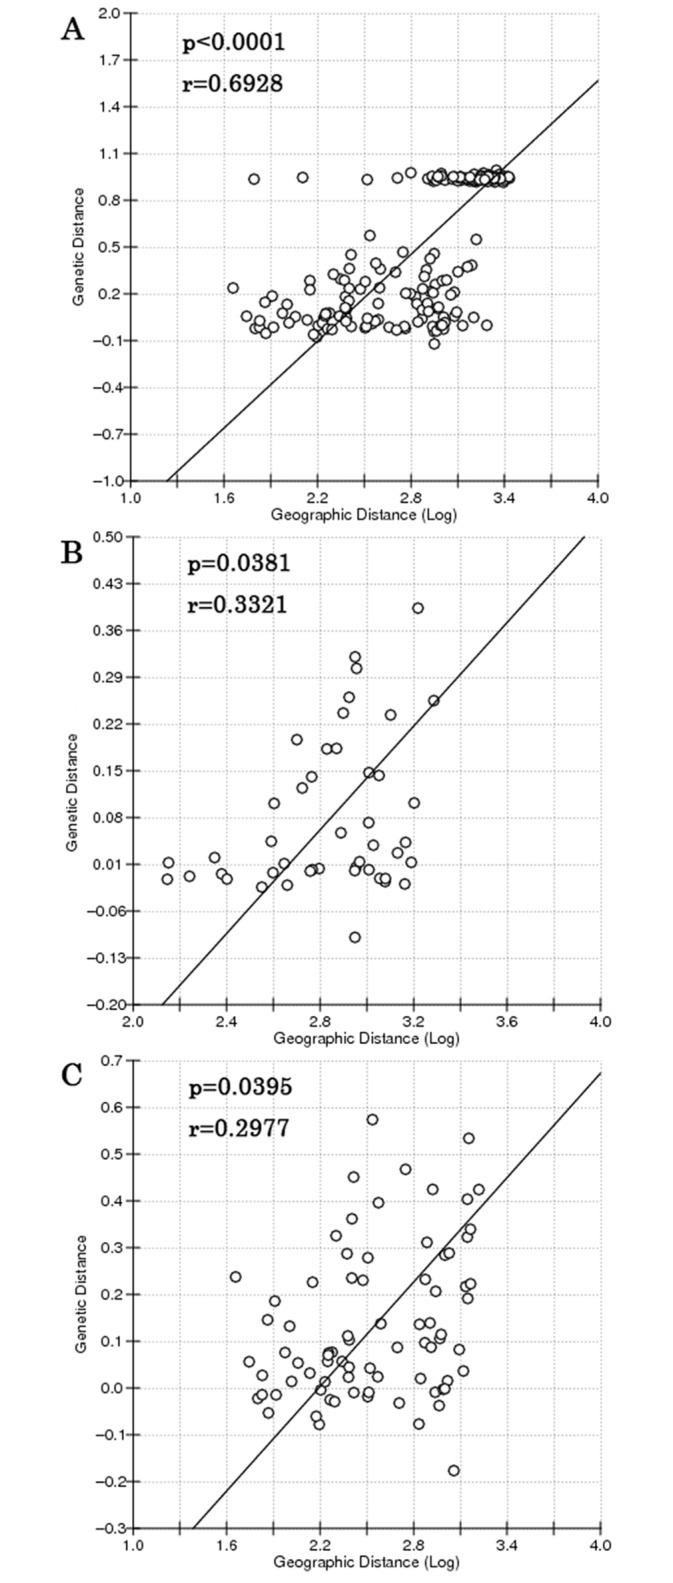
Relationship between genetic vs. geographical distance (log-transformed) in M. petechialis.A, all China populations except Wenzhou; B, the North populations; C, the South populations.